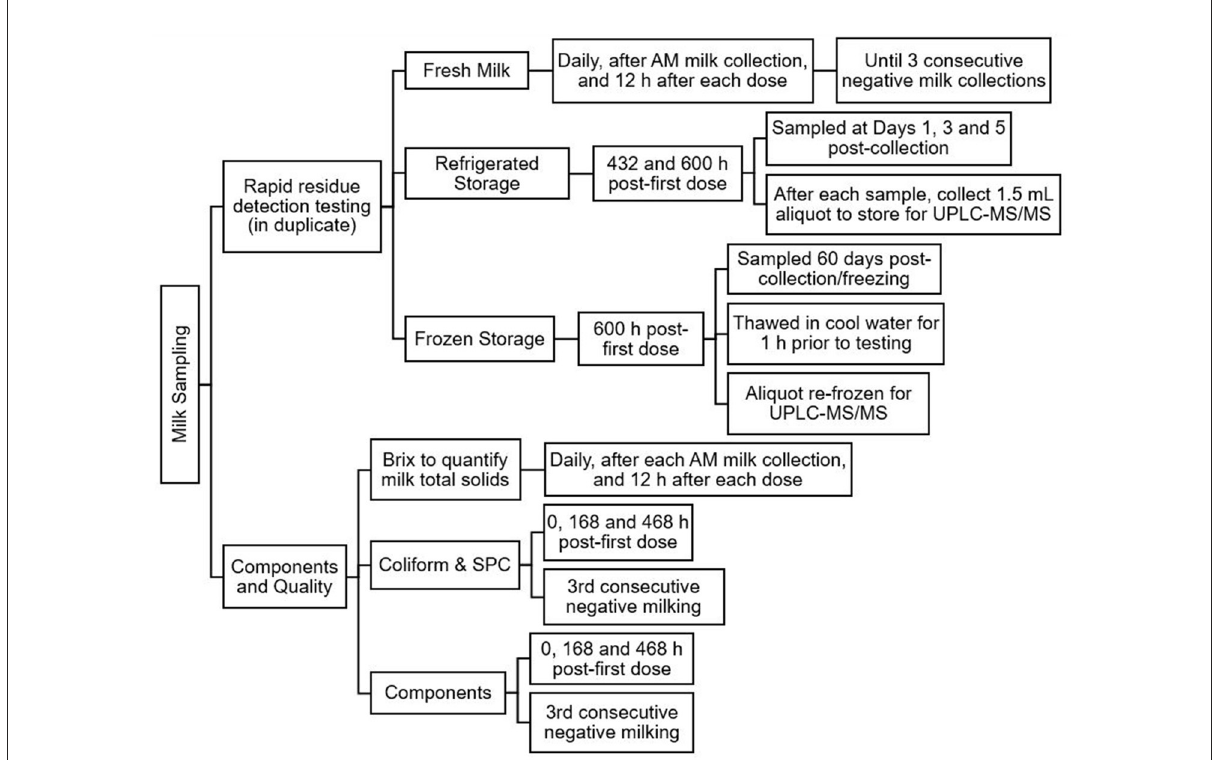
FIGURE1 Overview of the milk sampling protocol following treatment of lactating does with florfenicol 40 mg/kg subcutaneously twice, 4 days